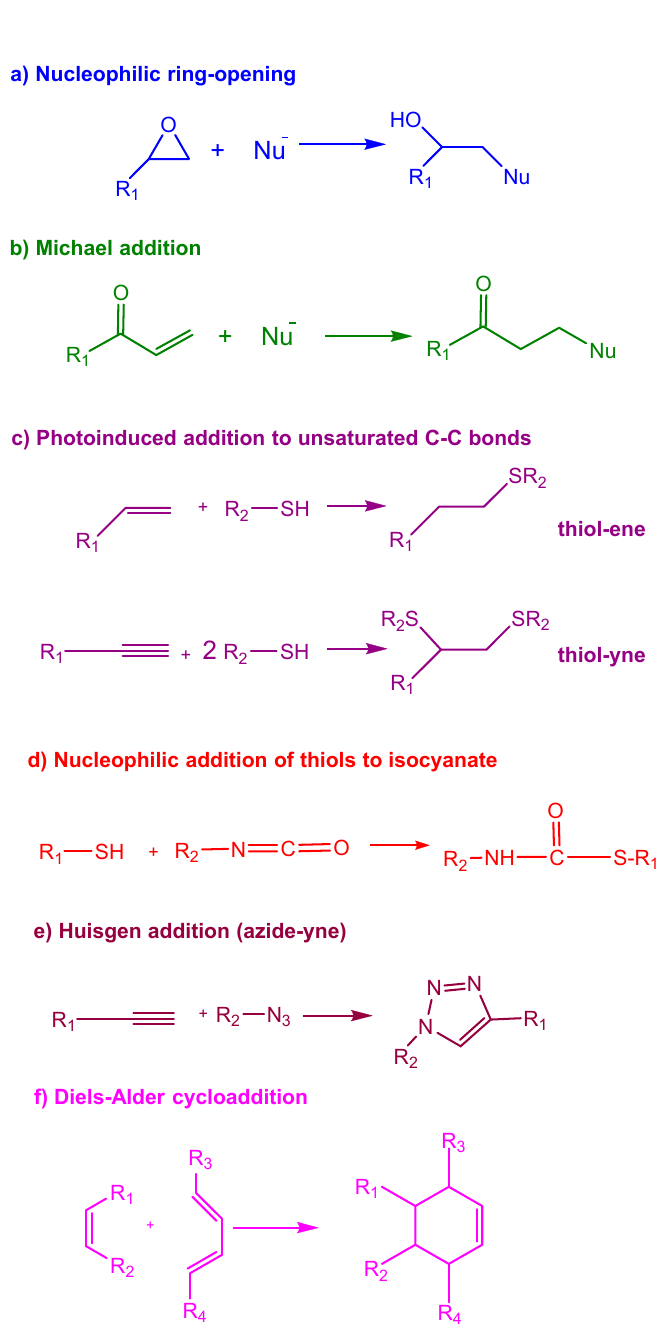
Scheme 1. Main click-type reactions used in the preparation of thermosets.